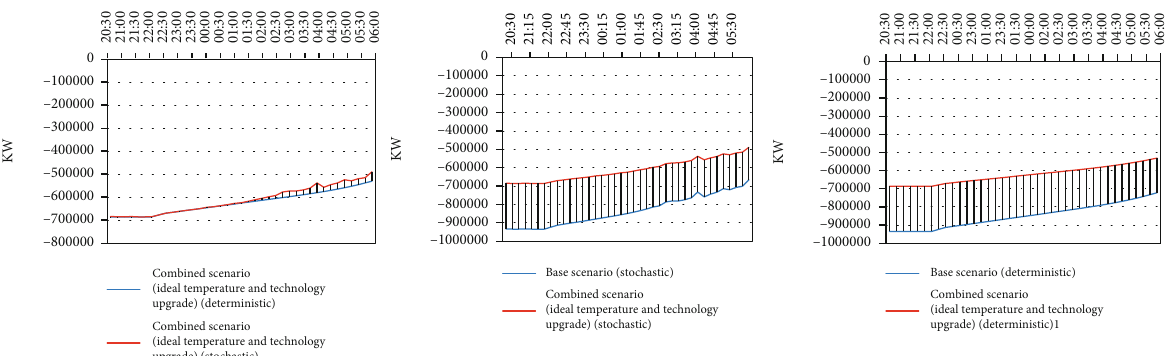
Figure 31: Di ff erent modes in the combined scenario (ideal temperature and technology upgrade) (night).